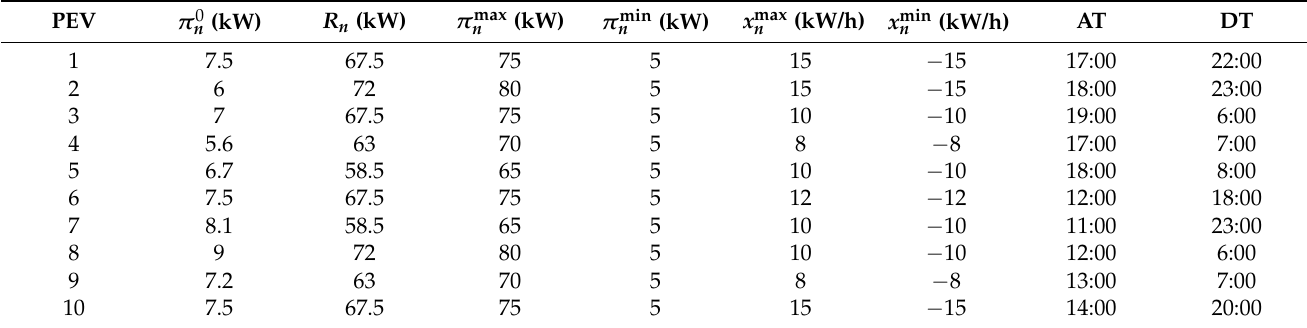
Table 1. PEV parameter settings.